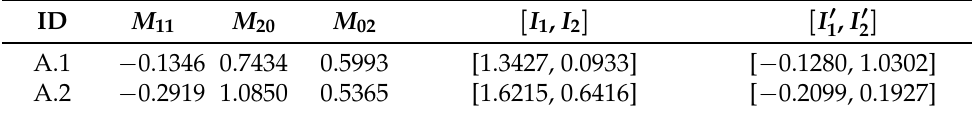
Table 4. The values of moments for the examples